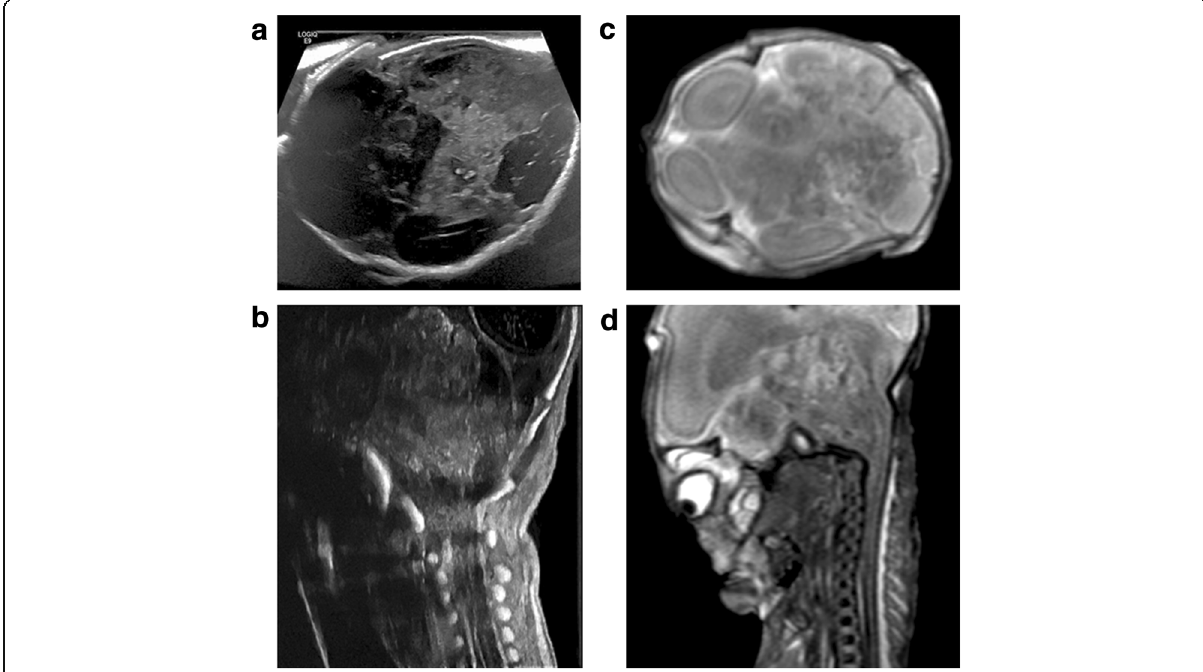
Fig. 7 In the same foetus at 21 weeks gestation, described in Fig. 6, there were several intracranial abnormalities. Post-mortem ultrasound images of the brain in axial plane ( a ) and the cervical spine in sagittal plane ( b ) are matched with corresponding T2-weighted post-mortem MRI images ( c , d ). Both imaging modalities were acquired 7 days after delivery. This infiltrating intracranial mass affecting the brainstem and both temporal lobes was also a teratoma. The lesion is mostly echogenic on ultrasound but of heterogenous signal intensity on MRI